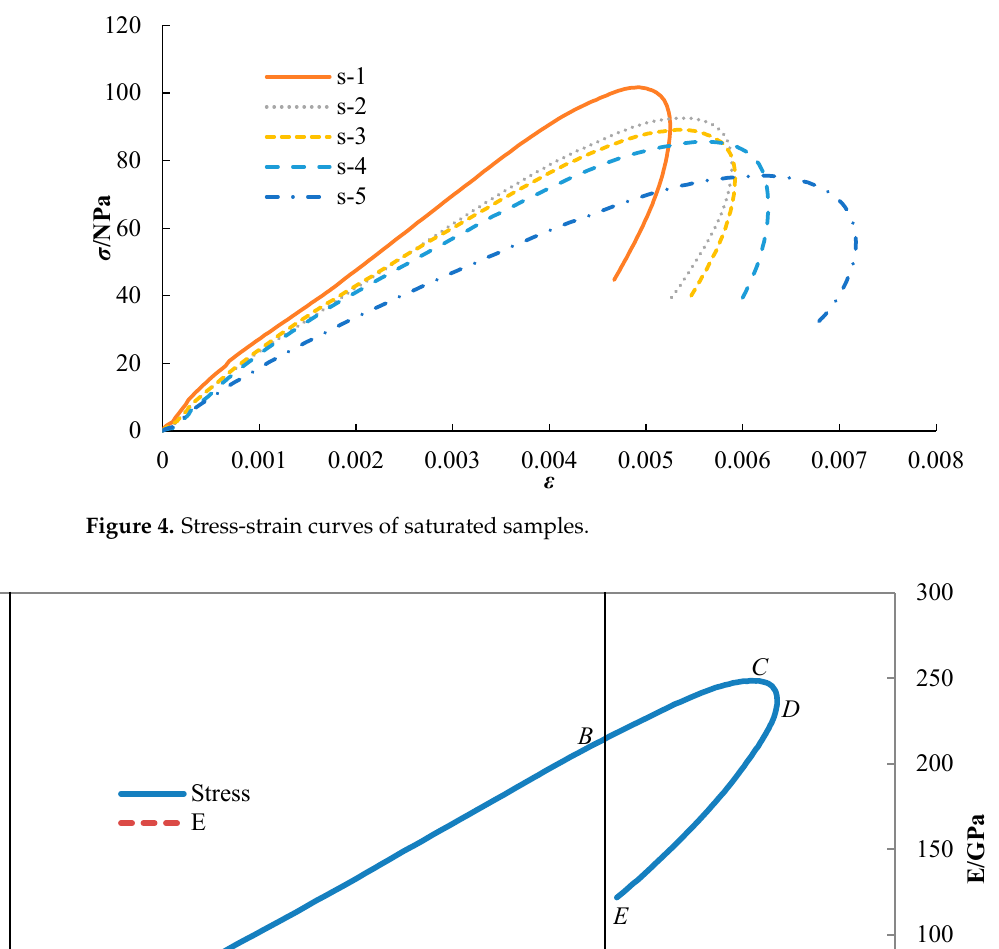
Figure 3. Stress ‐ strain curves of half ‐ saturated samples.